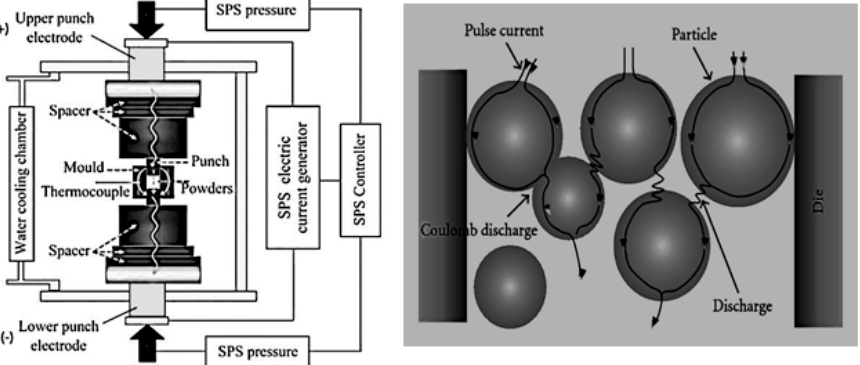
Figure 8. Schematic illustration of the features of SPS [39].